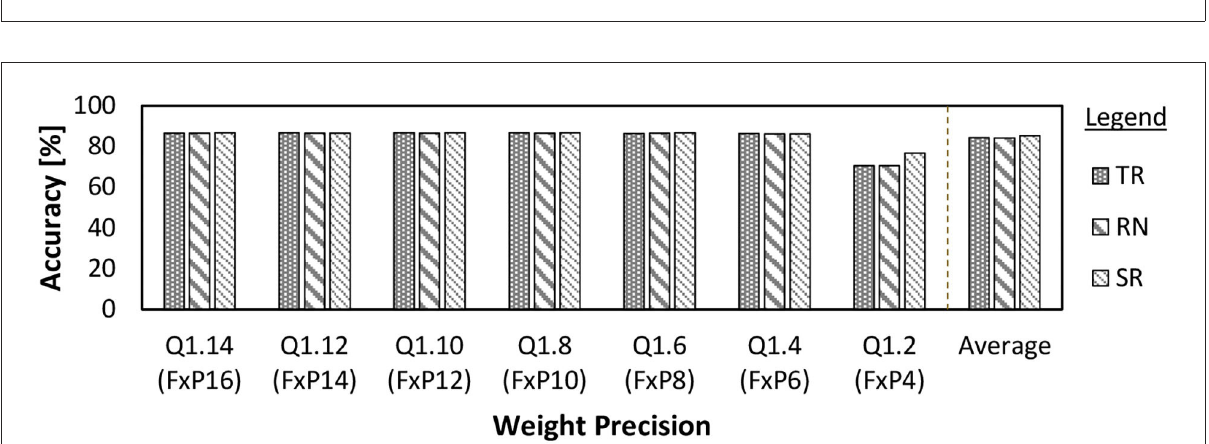
FIGURE5 The EnforceSNN framework and its novel mechanisms (highlighted in blue boxes).